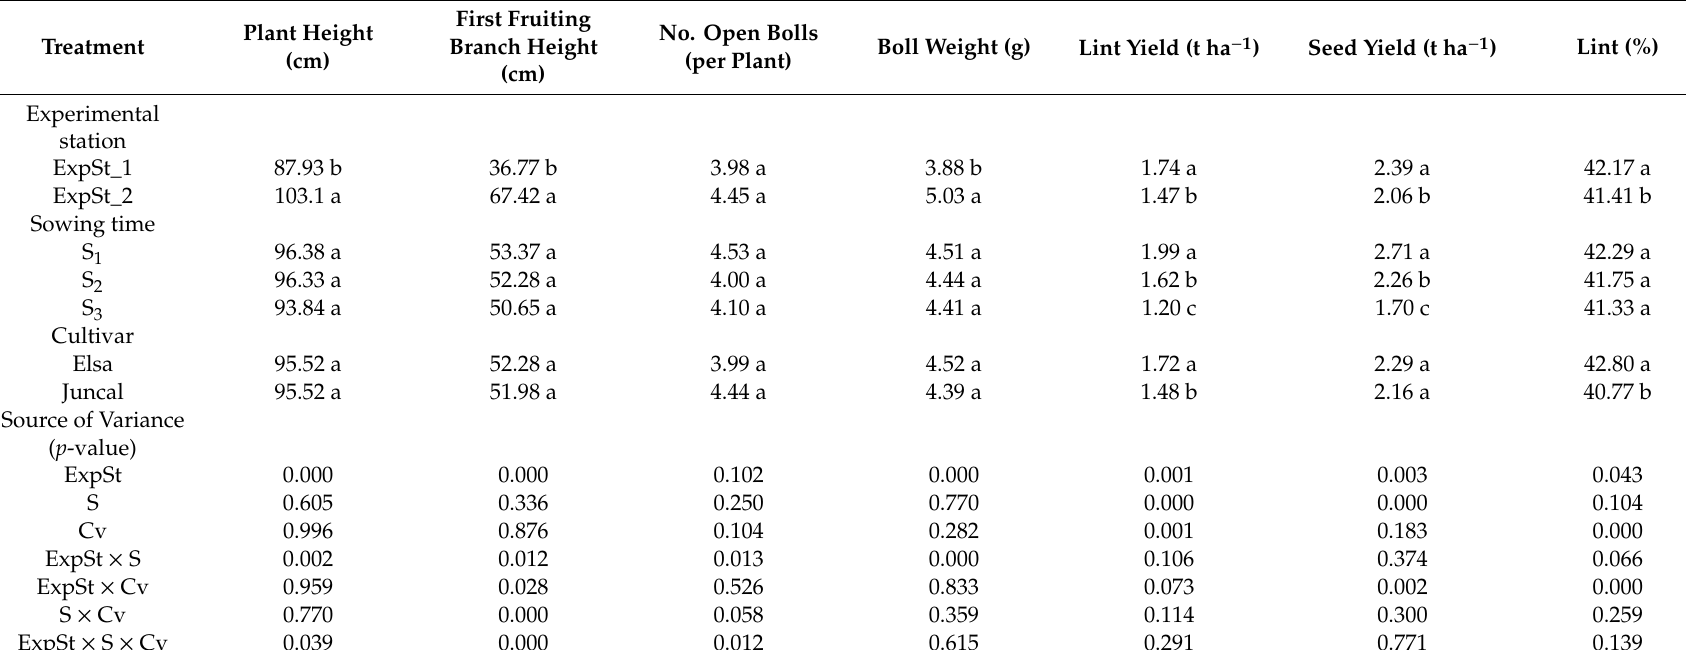
Table 6. Cotton plant growth characteristics, yield and yield components in response to di ff erent experimental stations, sowing times and cultivars during the year